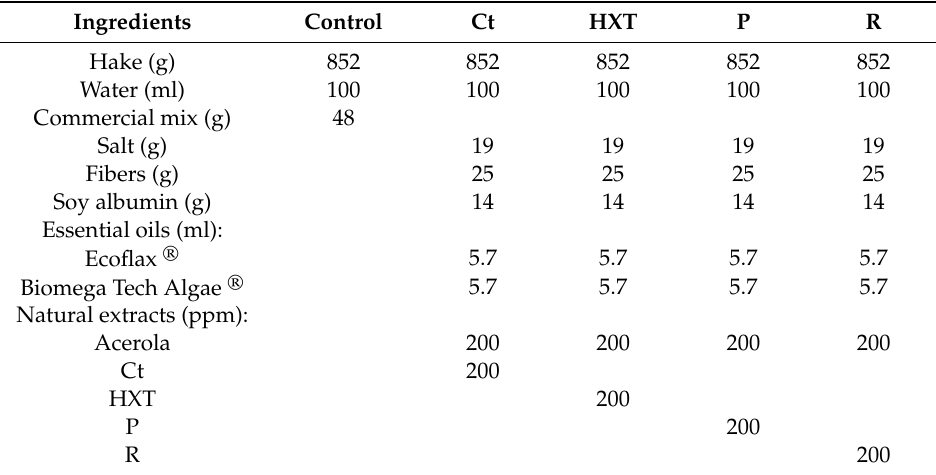
Table 6. Ingredients (g) of reformulated fish patty